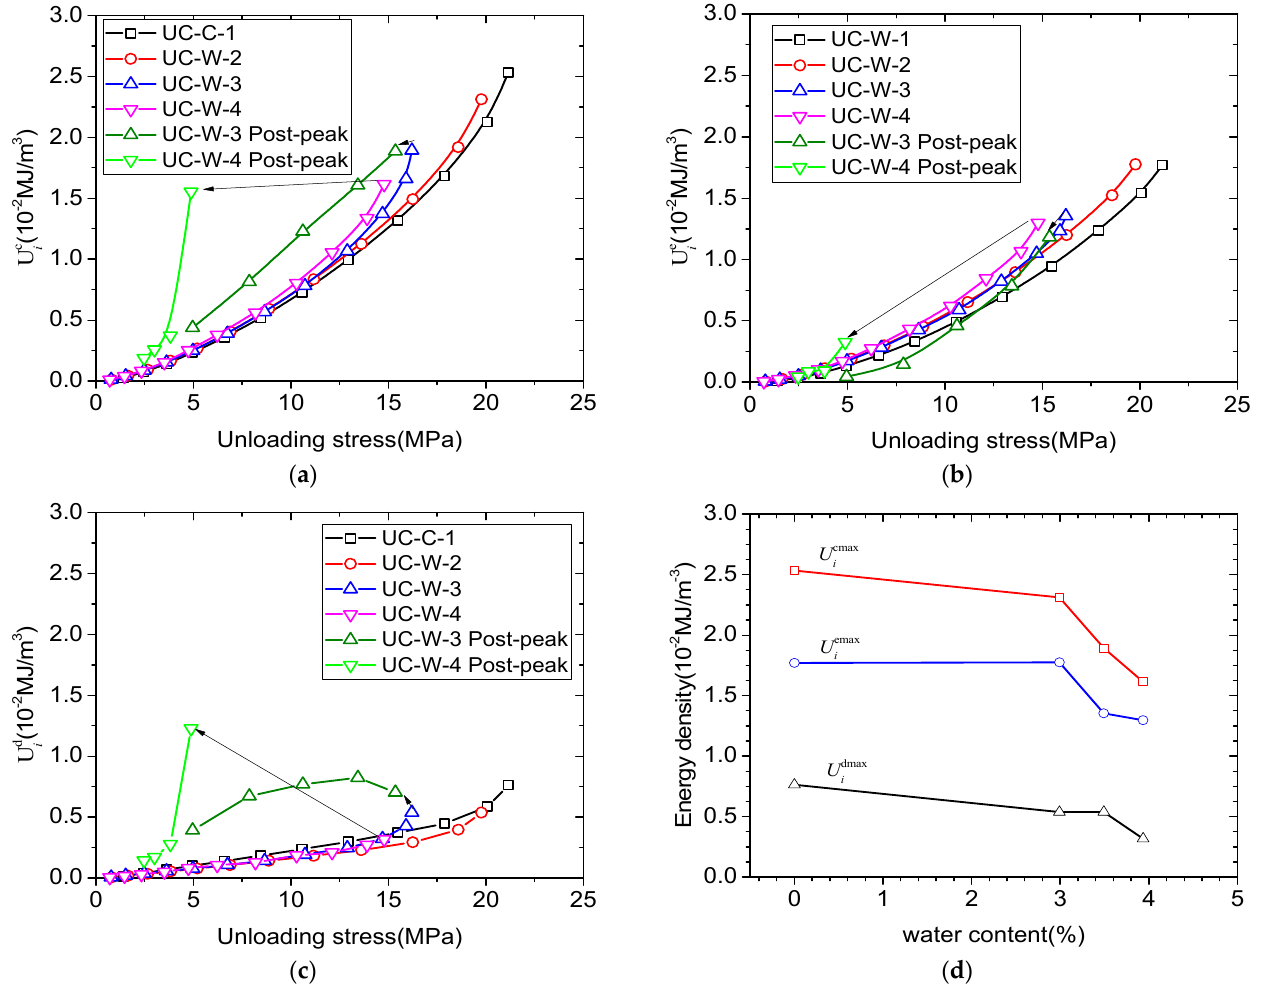
Figure 14. Relationship between energy density and unloading stress: ( a ) input energy density, ( b ) elastic energy density, ( c ) dissipated energy density, and ( d ) relationship between peak energy density and water content.